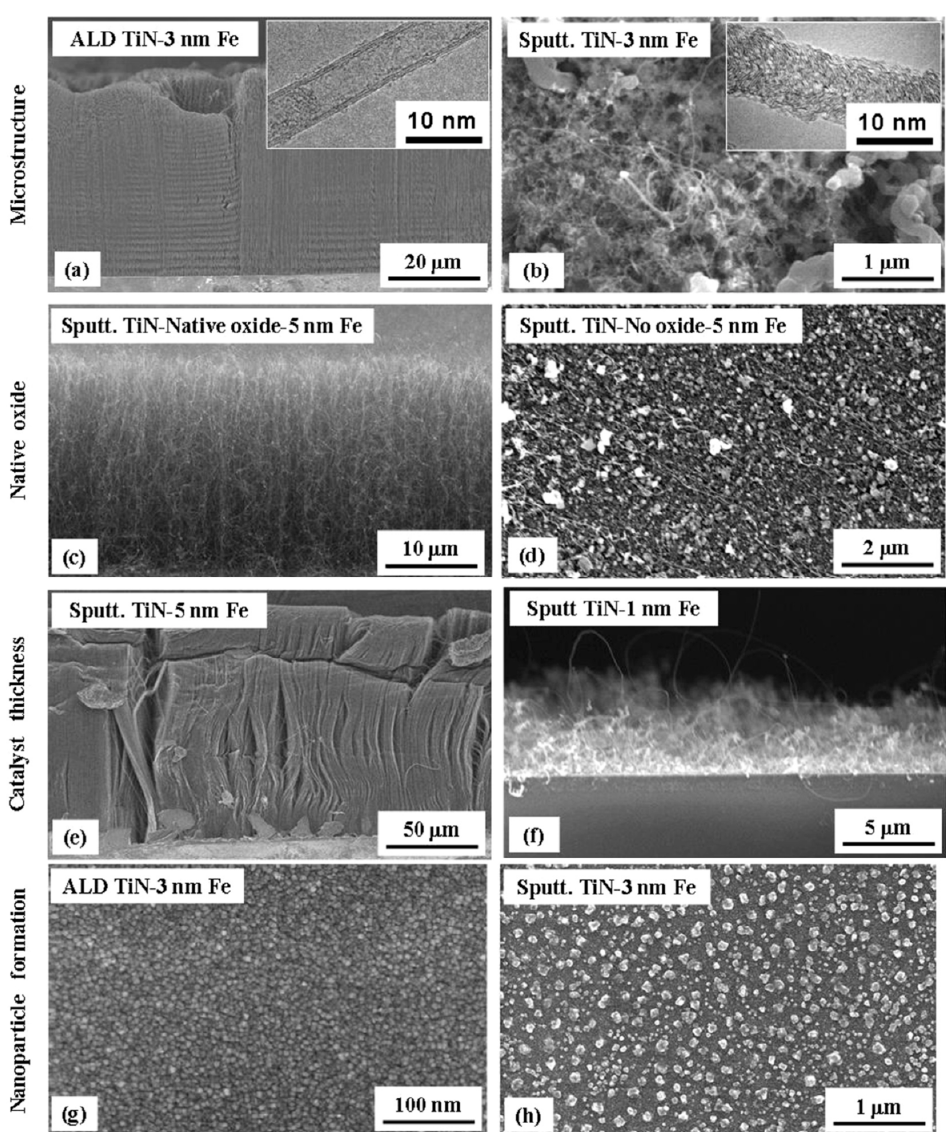
Figure 18. The effect of: ( a , b ) the microstructure (deposition technique); ( c , d ) presence of native oxide; catalyst thickness ( e , f ) over the growth of VACNT presented through a comparison of SEM micrographs. SEM images ( g , h ) present the density of Fe nanoparticles on DBL formed via the ALD or PVD process, respectively. Idem after growth of VACNT in ( a , b ). Note that the DBLs, shown ( c ) or ( e ), were PVD deposited at 10 − 4 or 10 − 1 mbar and provided different support of VACNT, respectively. Reprinted with permission from S.Esconjauregui, Carbon; Ref. [86] copyright 2014, Elsevier.